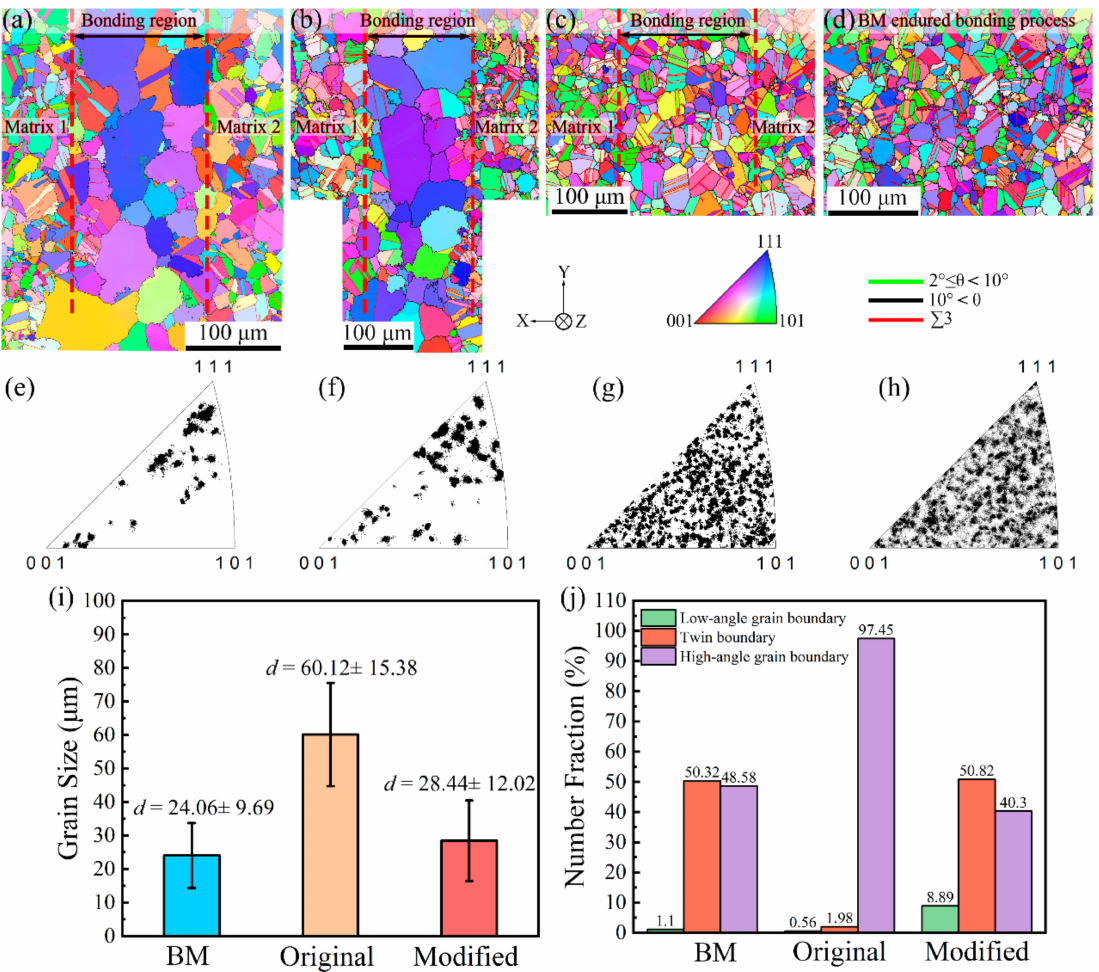
Figure 2. EBSD patterns of FGH96 SSDB joints with different bonding processes and the BM endured the bonding thermal cycle. ( a , b ) Orientation image microscopy (OIM) maps in the X-direction (the normal direction of the bonding interface) of the joint bonded by the original bonding process. ( c ) The OIM map in the X-direction of the joint bonded by the modified bonding process. ( d ) The OIM map for the BM endured the welding thermal cycle. ( e – h ) The corresponding orientation distribution for the grains in the bonding region in ( a – c ), and the grains in the BM in ( d ). The grain size ( i ) and grain boundary character distribution (GBCD) ( j ) for the grains in the bonding region and BM.